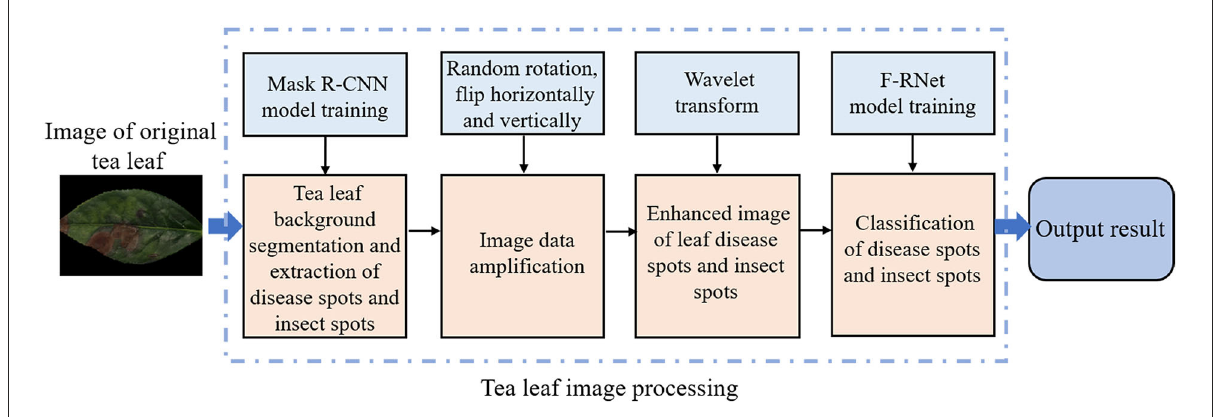
FIGURE1 The overall framework of the model in this